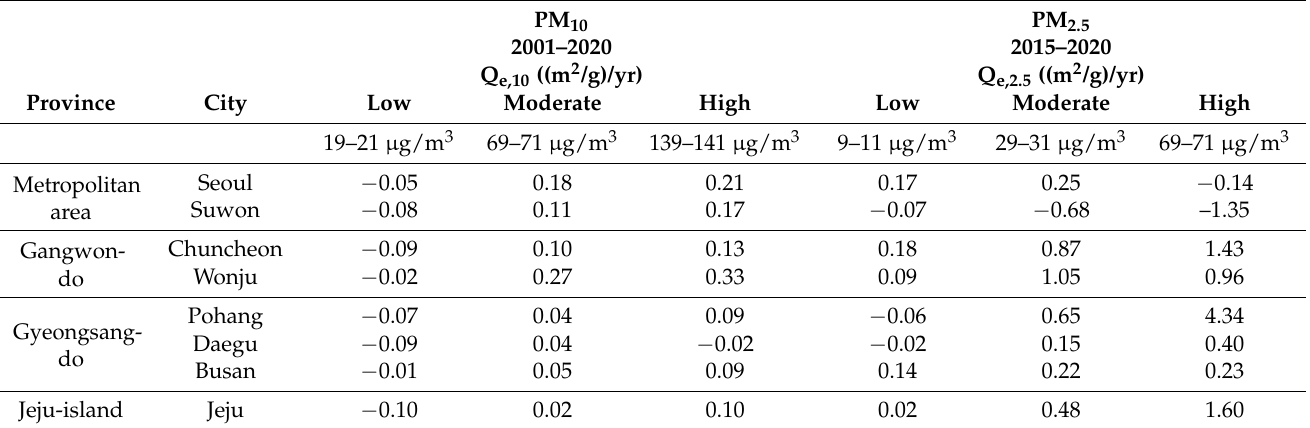
Table 8. Annual Q e trend slope for each concentration category of PM 10 and PM 2.5 based on linear regression